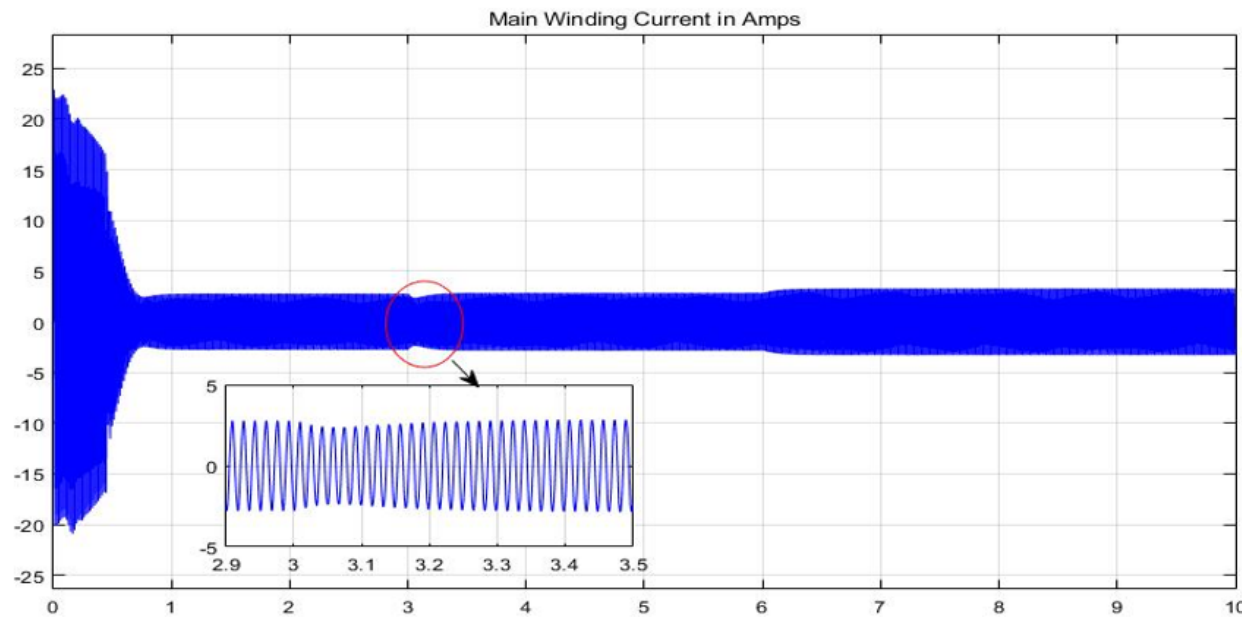
Figure 18. Main winding current for various load torque.